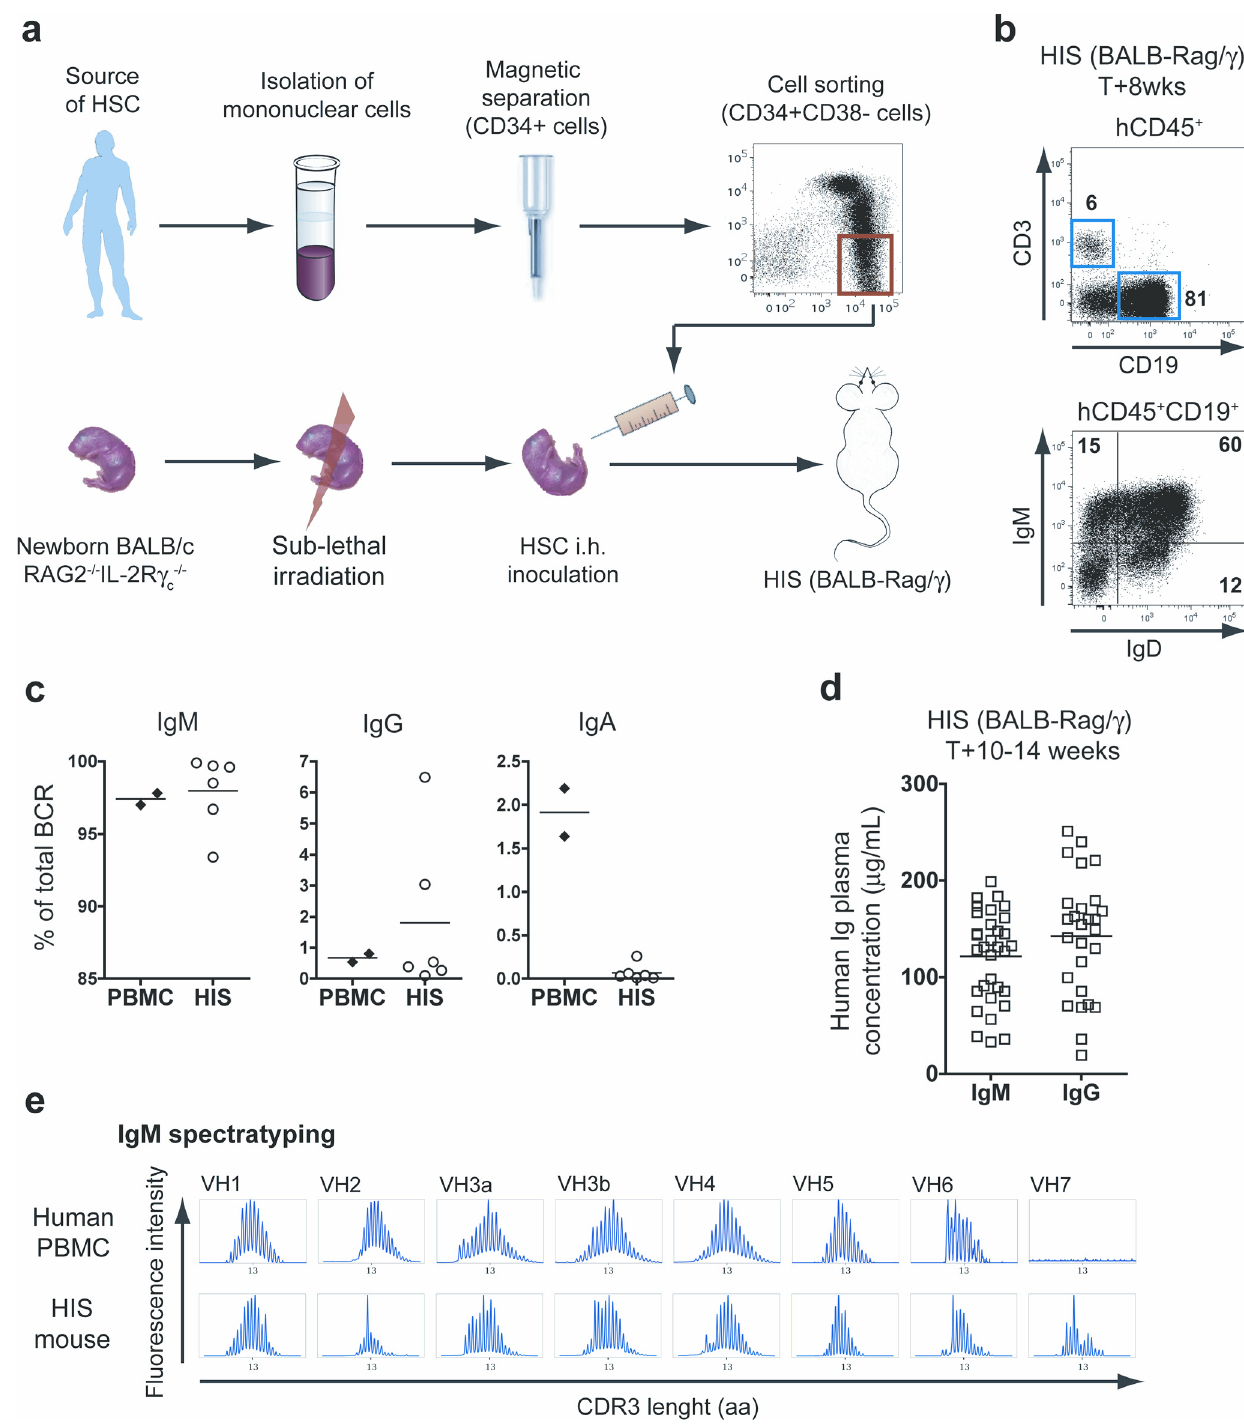
Figure 1. Characterization of B cells in naı¨ve HIS mice. (A) HIS mice are generated by transplanting sorted human CD34 + CD38 2 HSC-enriched cell fraction into conditioned (3.5 Gy irradiation) newborn Rag2 2 / 2 IL-2R c c 2 / 2 mice. After 6 to 8 weeks post-transplantation, human lymphoid and myeloid cell subsets are found in the blood and lymphoid organs of the reconstituted animals. (B) The top panel shows the flow cytometry analysis of human T (CD3 + ) and B (CD19 + ) cells found in the spleen of 8-week old HIS mice. The expression of IgM and IgD on the surface of B cells is depicted on the low panel. (C) The relative proportion of B cells expressing an IgM, IgG or IgA BCR was determined by quantitative PCR for both control PBMC and HIS splenocytes. Percentages represent the frequency of IgM, IgG and IgA (C H m , C H c and C H a ) containing V H PCR products out of the total V H PCR products from each spleen. The horizontal bars indicate the mean value. (D) The graph shows the concentration of total IgM and IgG (mean values: horizontal bars) in the plasma of 10- to 14-week old naive HIS mice. (E) The naive IgM B cell repertoire of HIS mice was evaluated on splenocytes by performing a BCR immunoscope for each V H family. The profiles obtained with control human PBMC are also shown.